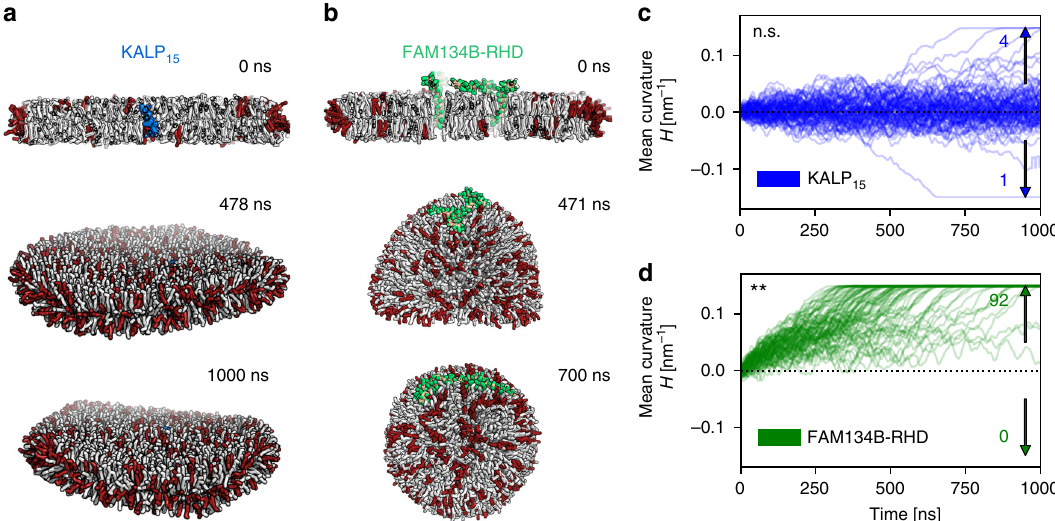
Fig. 3 Bicelle-to-vesicle transitions. a , b Snapshots showing curvature of bicelles containing DMPC (gray) and short chain DHPC lipids (red) ( a ) with KALP 15 peptide (blue) and ( b ) FAM134B-RHD (green). c KALP 15 -containing bicelles remain fl at with low curvature (| H | = ±0.005 nm − 1 ), rarely displaying vesiculation events (5/96) within 96 simulations of 1000 ns each. d FAM134B-RHD actively curves the bicelle to form vesicles in repeated runs (92/95). FAM134B-RHD induces strong positive curvature along the cytoplasmic lea fl et resulting in positively curved vesicles ( H = + 0.16 nm − 1 ). c , d Curvature time-traces (blue/green, smoothed running averages over 11 ns widows) from individual replicates quantify the bicelle shape transformation process during simulations. **Denote and n.s. denote the one-tailed probability in binomial tests for bias in number of vesiculation events with positive and negative